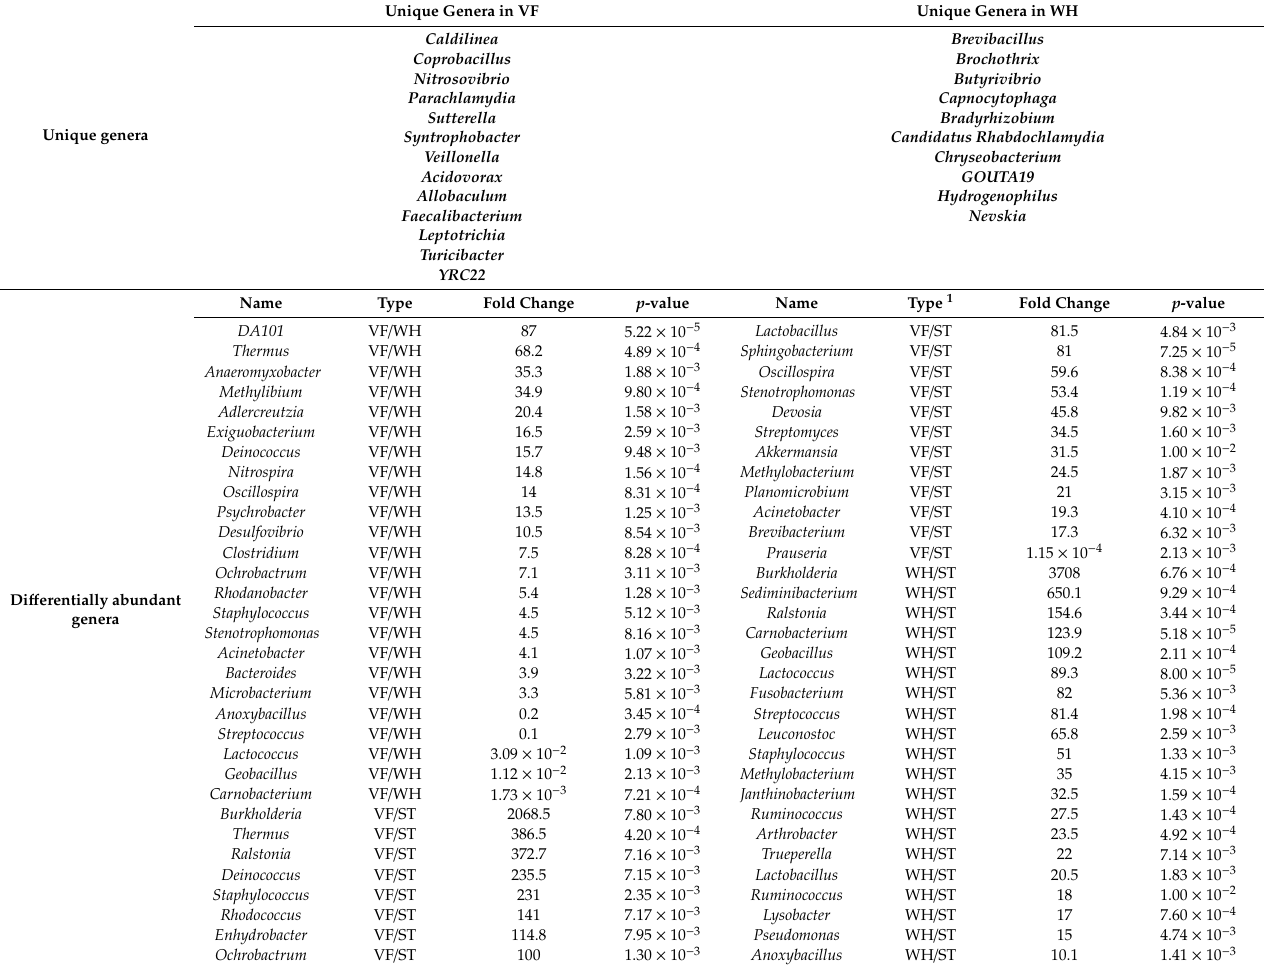
Table 2. Unique and di ff erentially abundant genera within VF, WH, and